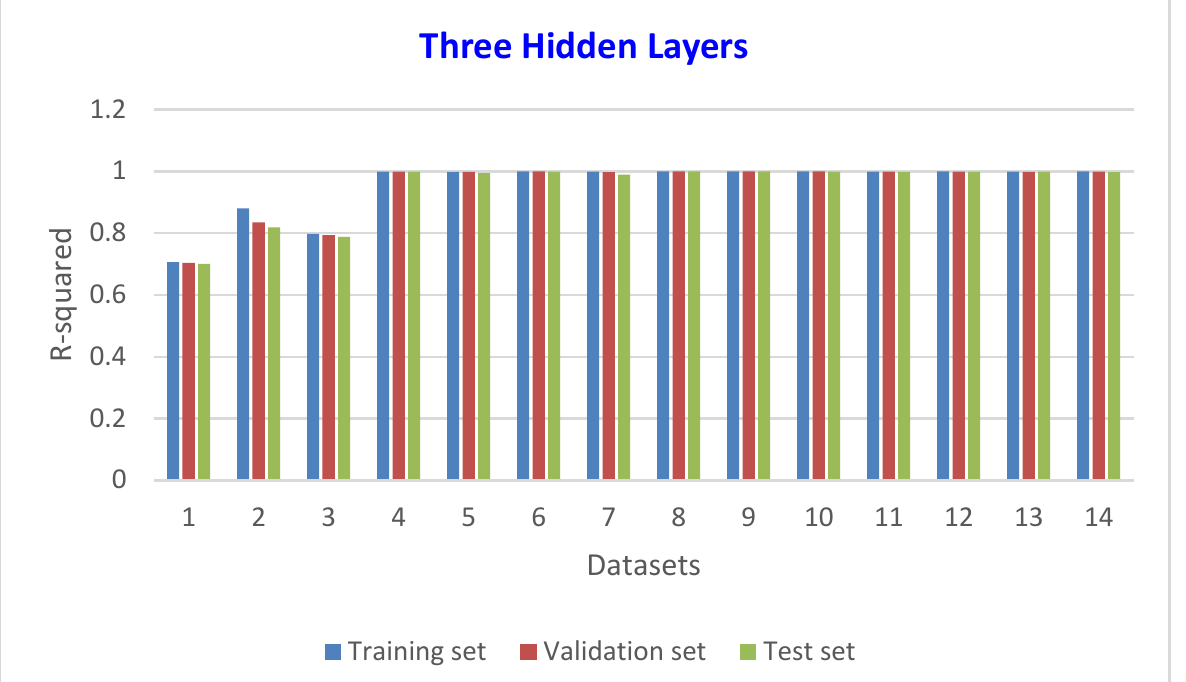
Table 9. Optimized parameters for the final model for three hidden layers.